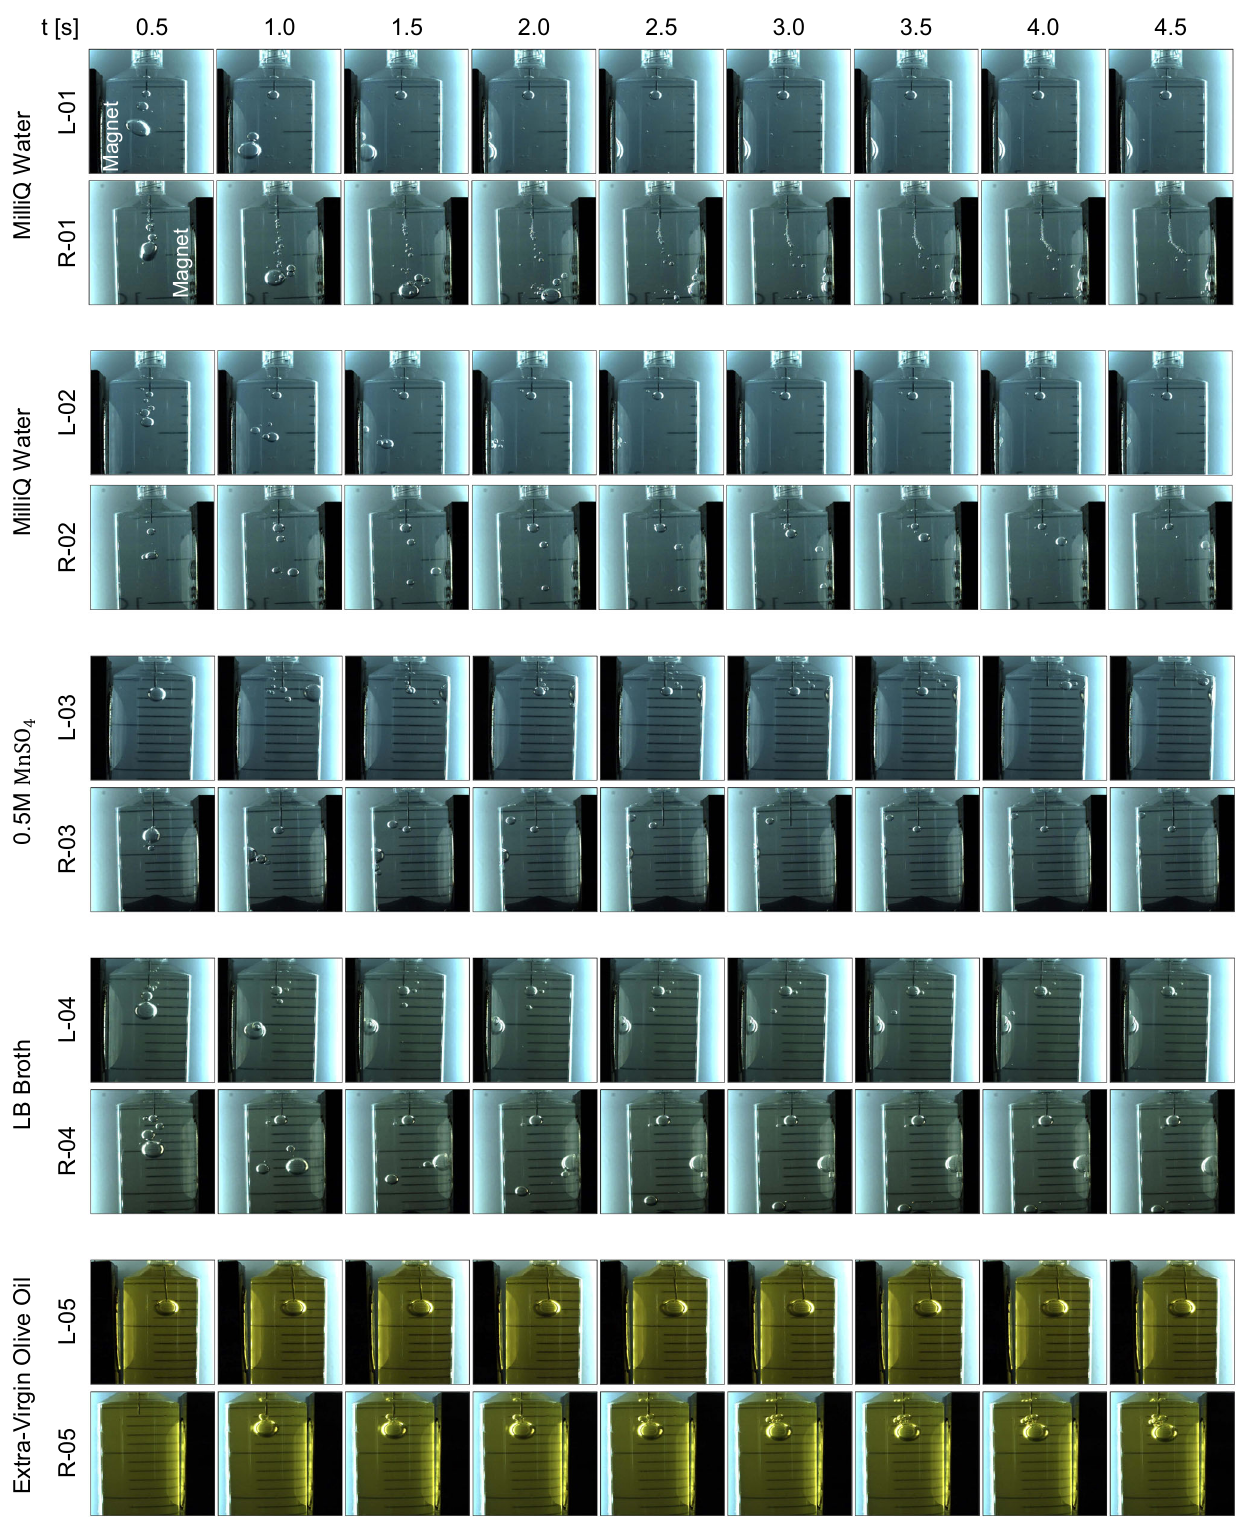
Fig. 2 Overview of dia- and paramagnetic results for left (L) and right (R) magnetic con fi gurations and the fi ve drop experiments. The injection and displacement of air bubbles are shown as a function of where η is the dynamic viscosity of the liquid, describes the ratio of inertial to viscous forces and is kept below 50 in this work, as shown later on. The combination of low We and moderate Re numbers results in spherical bubbles with no-zigzag motions.